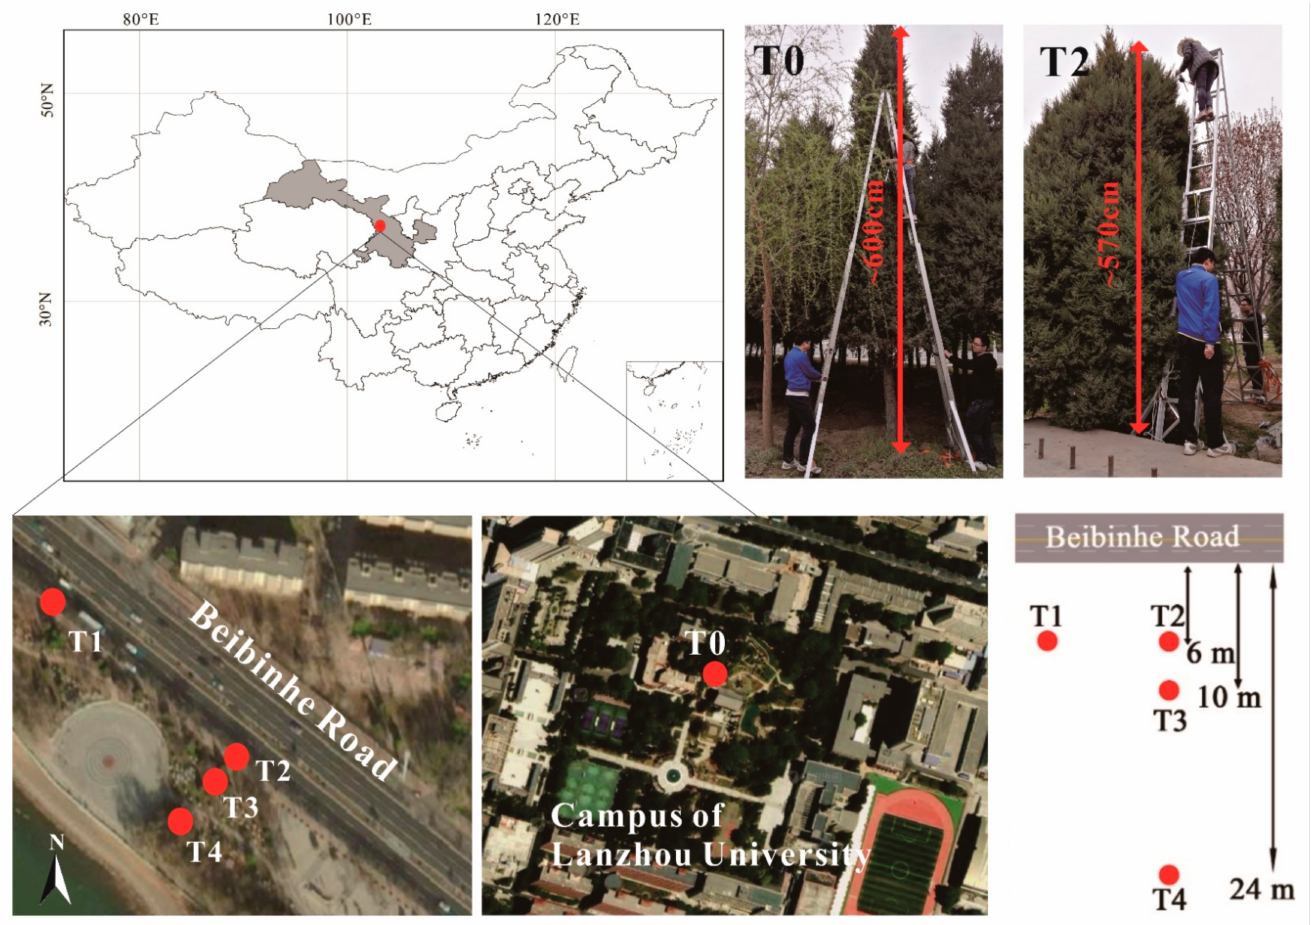
Figure 1. Sampling location in